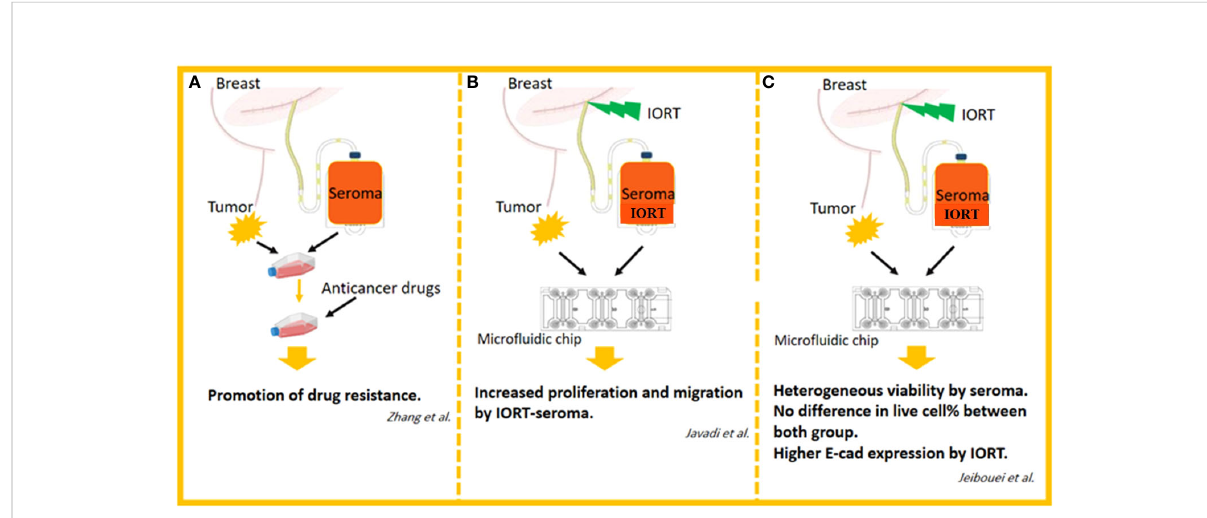
FIGURE 6 The studies related to the effects of seroma on primary BC cells. (A) Effects of drugs on seroma-treated human-derived breast cancer cells in 2D cell culture system. (B) Effects of IORT-treated and non-IORT-treated seroma on human-derived breast tumor spheroids in 3D micro fl uidic chips (visual evaluation of proliferation and migration). (C) Effects of IORT-treated and non-IORT-treated seroma on human-derived breast tumor spheroids in 3D micro fl uidic chips (visual and molecular evaluation of proliferation, apoptosis, migration, and